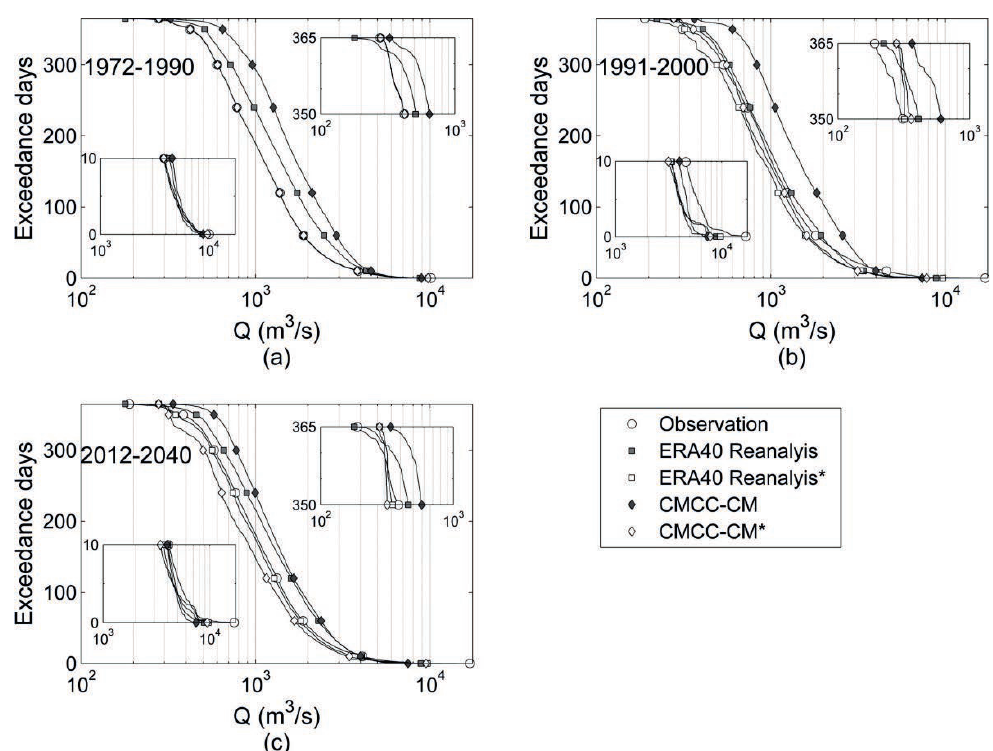
Fig. 3 Comparison among FDCs in: (a) calibration, (b) validation and (c) future periods. Original and corrected (indicated with * in the legend) FDCs are reported for comparison. In panel (c), the future FDCs are compared with the FDC of the reference simulation over the period 1972–2000. In each panel, the insets are a zoom on highest (left) and lowest (right) discharges. The symbols are not representative of all points used to build the FDCs. The simulations are labelled according to the climate data used to force them: observations, COSMO–CLM driven by ERA40 Reanalysis or COSMO-CLM driven by CMCC–